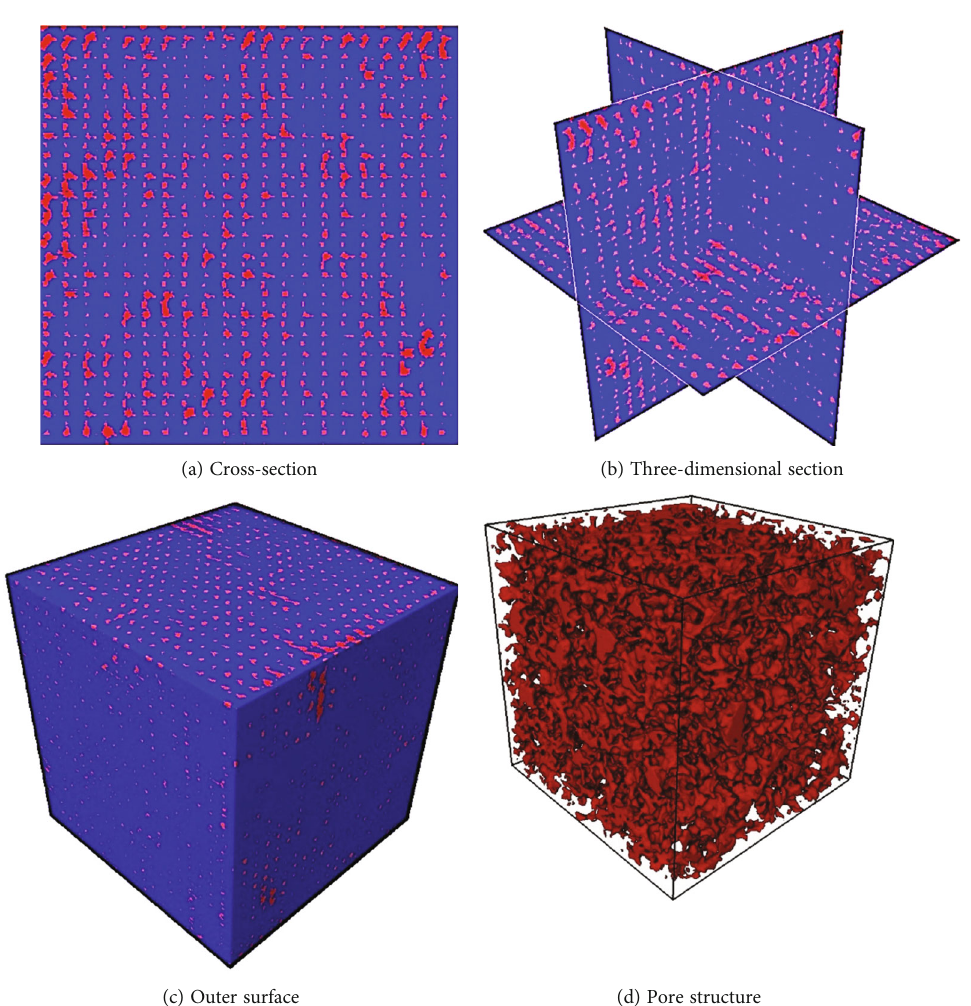
Figure 4: Digital core modeling based on no pretrained